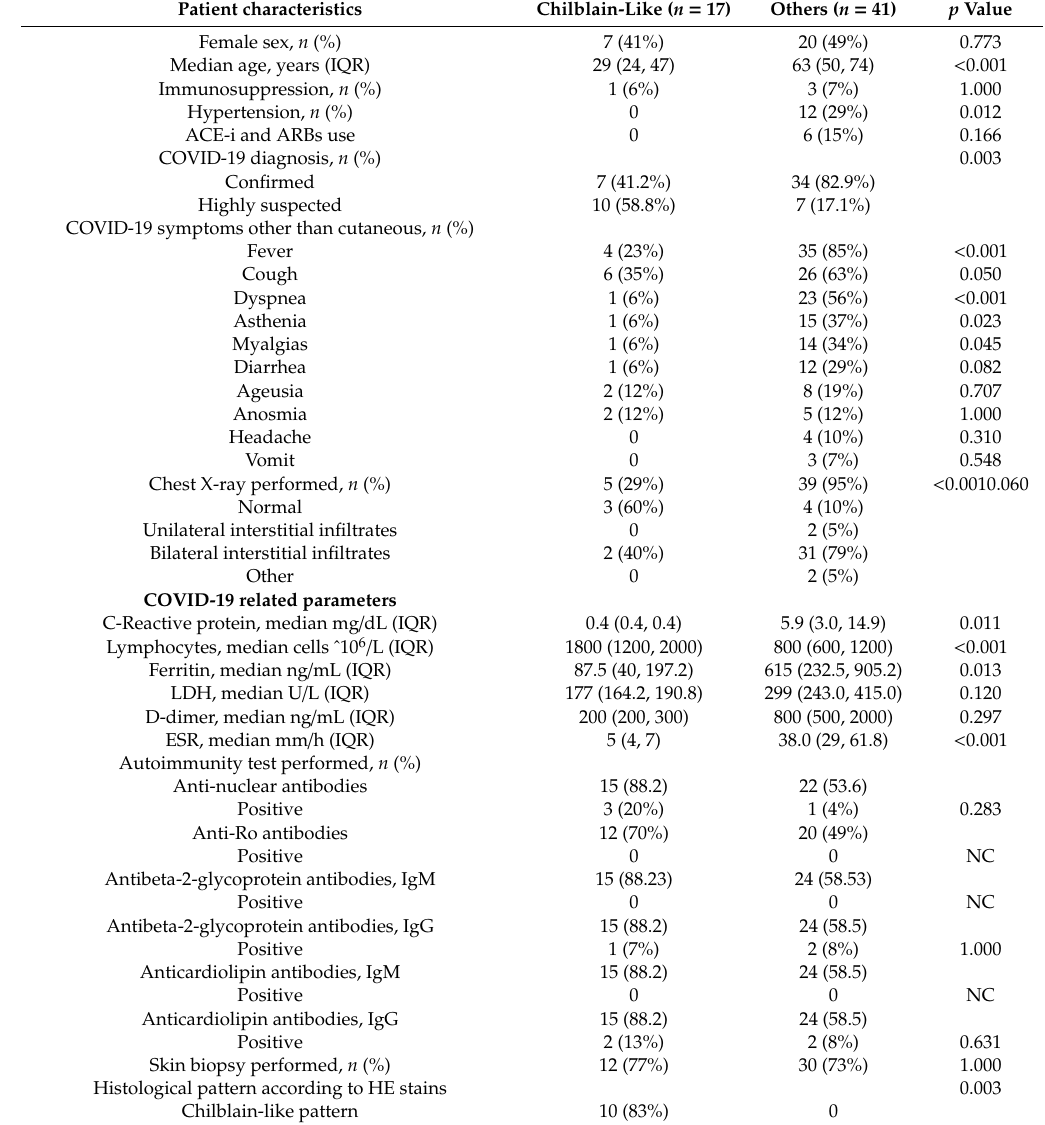
Table 2. Comparison of the characteristics of patients presenting with Chilblain-like. lesions and other types of skin